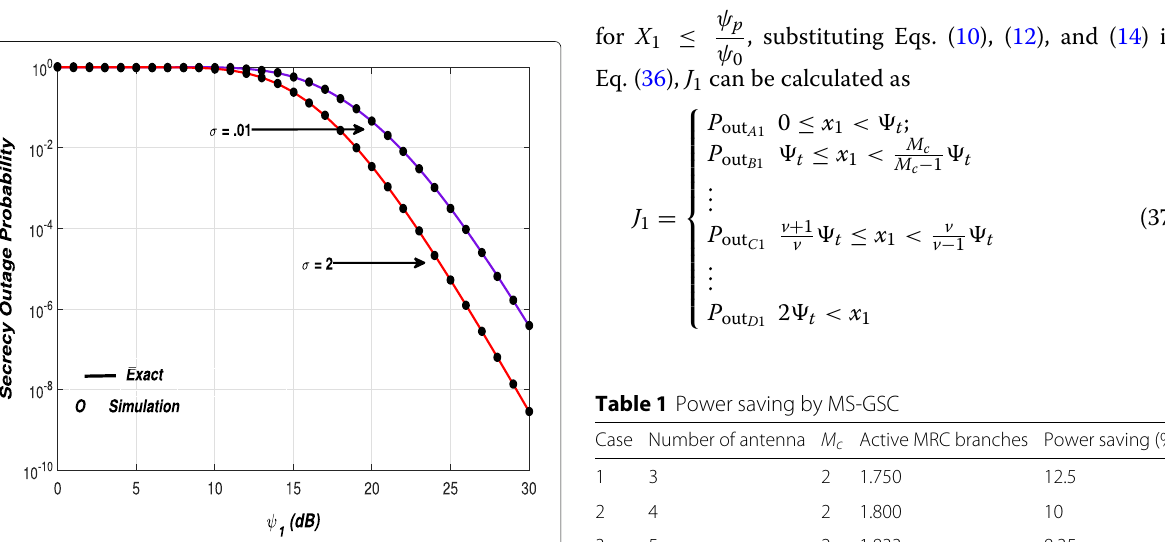
Fig. 4 Variation in secrecy outage probability with σ . Secrecy outage probability versus ψ 1 for different values of σ with (cid:3) t = 5 dB, (cid:3) 2 = 10 dB, R s =1, M c = 6, and M = 7